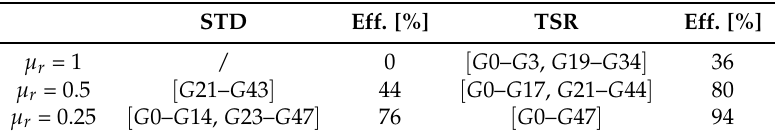
Table 3. Efficacy assessment of both approaches for the G16 standard for various stiction parameters. Efficiency is defined as the ratio of valid unbalance range and total unbalance range for said tolerance class [ G 0– G 50 ] .